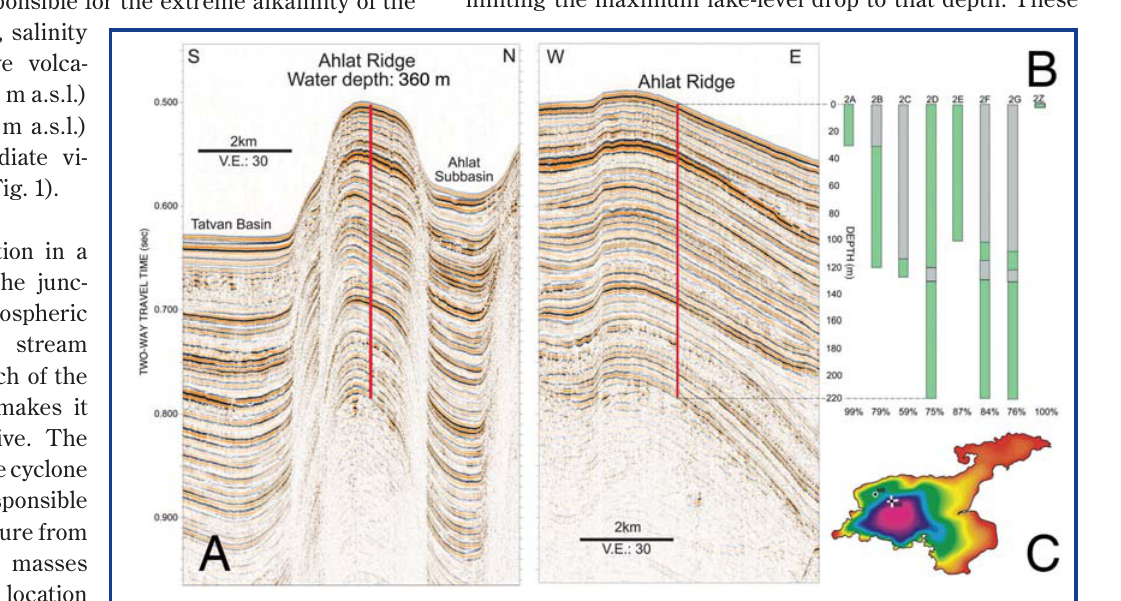
Figure 3. [A] S eismic lines crossing the Ahlat Ridge site. [B] Green bars show the cored sections of the multiple holes 2A–2G; 2Z is the gravity short core. The numbers give the recovery of the individual holes. [C] Location of drill site within lake bathymetry